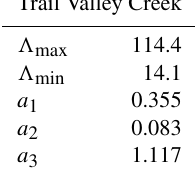
Table 2. Factory-fitting parameters used for Eq. (5) for the Trail Val- ley Creek shrub site. Values were obtained from the CRNS manu- facturer and are representative of a glacier landscape. The a 1 param- eter was adjusted from 0.313 to 0.355 to represent the high-porosity, saturated soils of the study